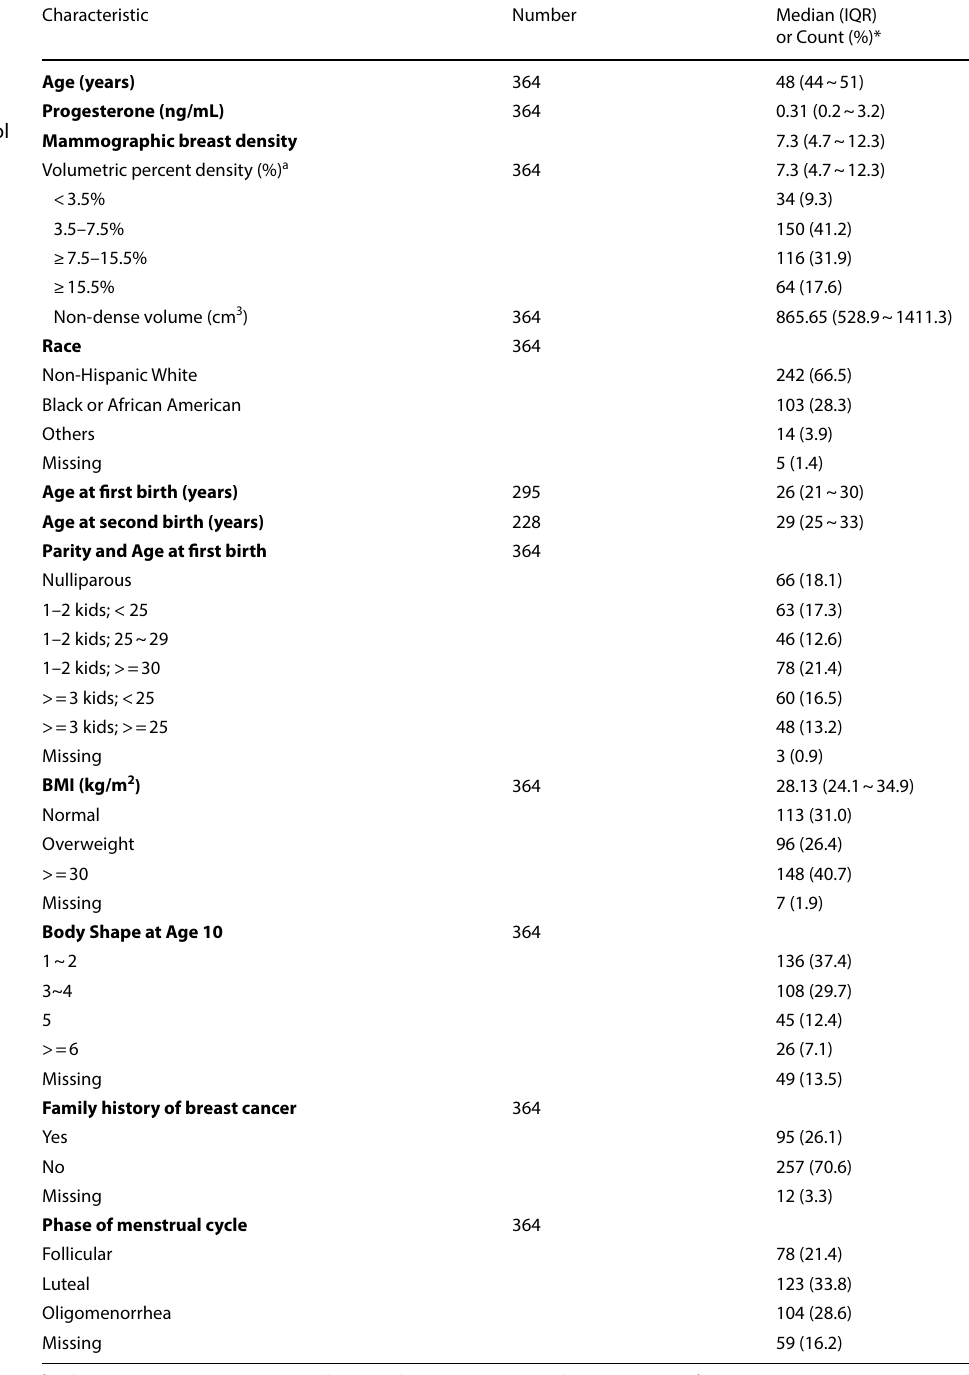
Table 1 Characteristics of study participants (n = 364) recruited at the Joanne Knight Breast Health